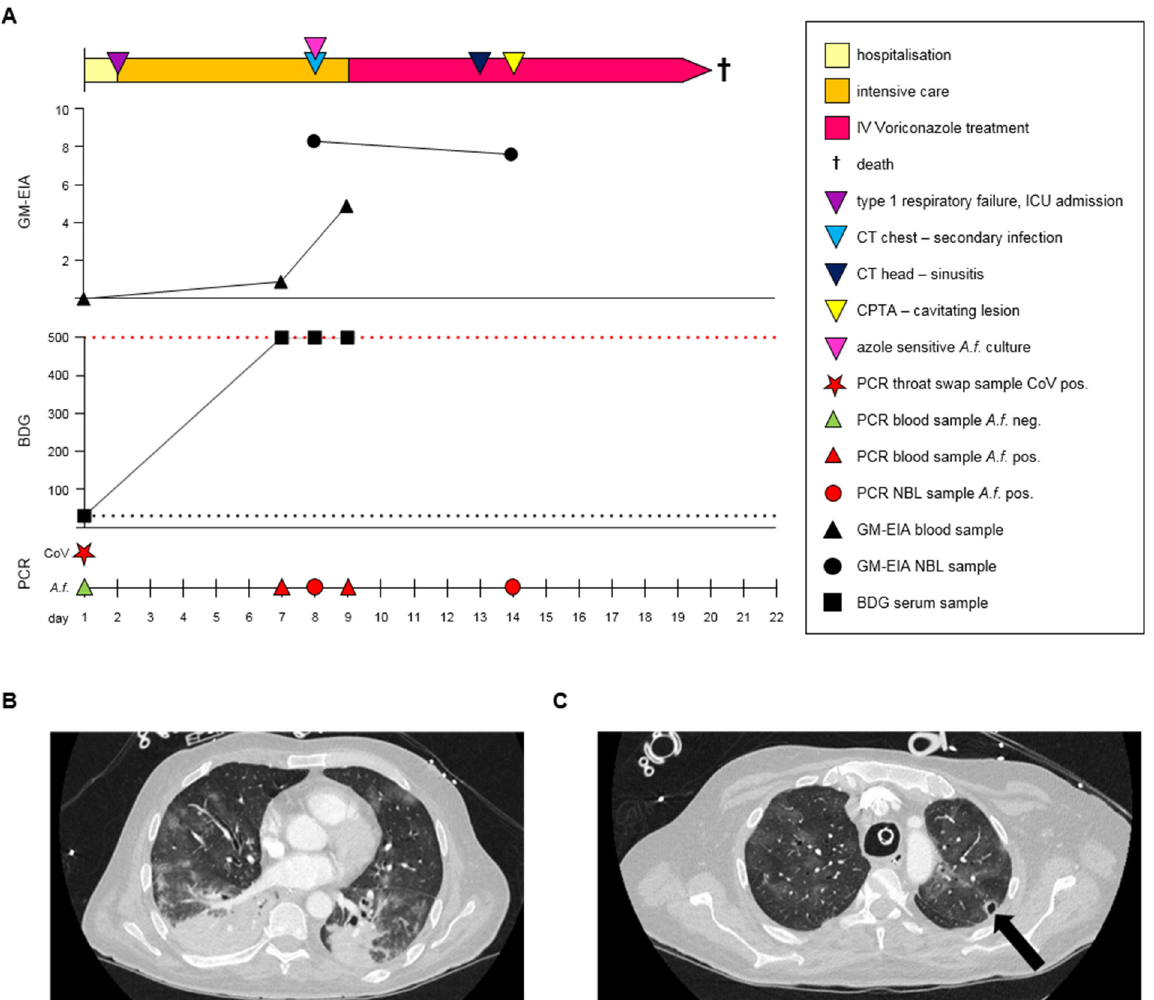
Figure 1. COVID-19-associated pulmonary aspergillosis (CAPA). ( A ) Clinical time course of CAPA in the case report patient. Key: BDG: (1-3)- β -D-Glucan, ICU: Intensive Care Unit, NBL: non-directed bronchial lavage fluid, IV: intravenous, GM-EIA: galactomannan enzyme immunoassay, CT: com- puted tomography scan, CTPA: CT pulmonary angiogram. ( B ) Extensive bilateral ground glass opacification and confluent consolidation. ( C ) CTPA showing ground glass opacification and a tiny new cavitary lesion in the left apex, indicated by the arrow.